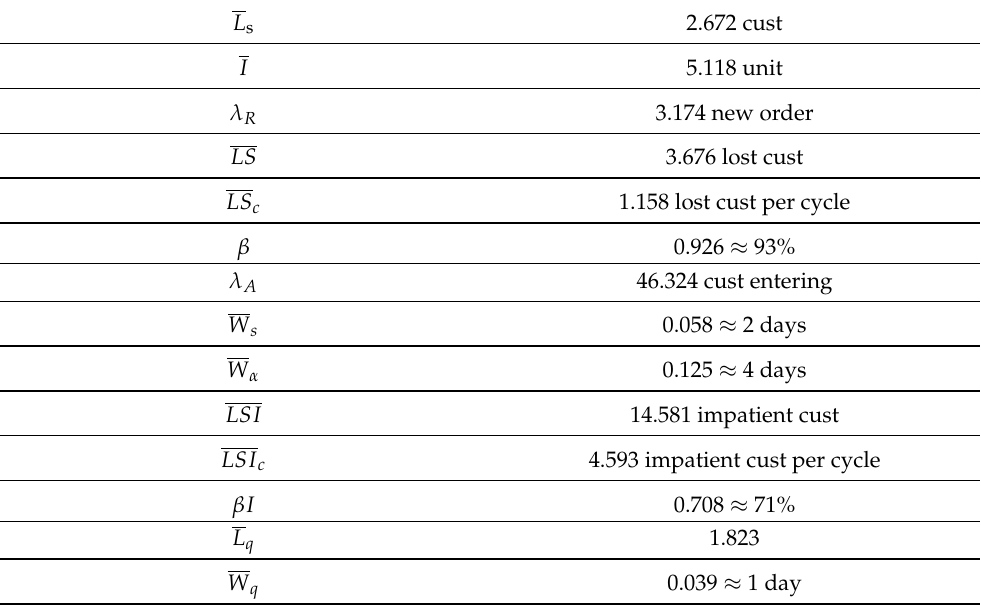
Table 1. The performance measures obtained using a deterministic order size model.